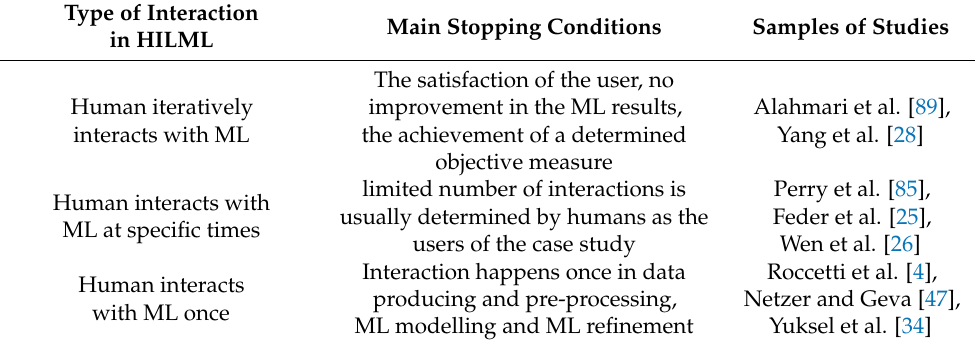
Table 1. How humans interact with ML in Human-In-the-Loop ML (HILML). Type of Interaction Main Stopping Conditions Samples of Studies in HILML The satisfaction of the user, no Human iteratively improvement in the ML results, interacts with ML the achievement of a determined objective measure limited number of interactions is Human interacts with usually determined by humans as the ML at specific times users of the case study Human